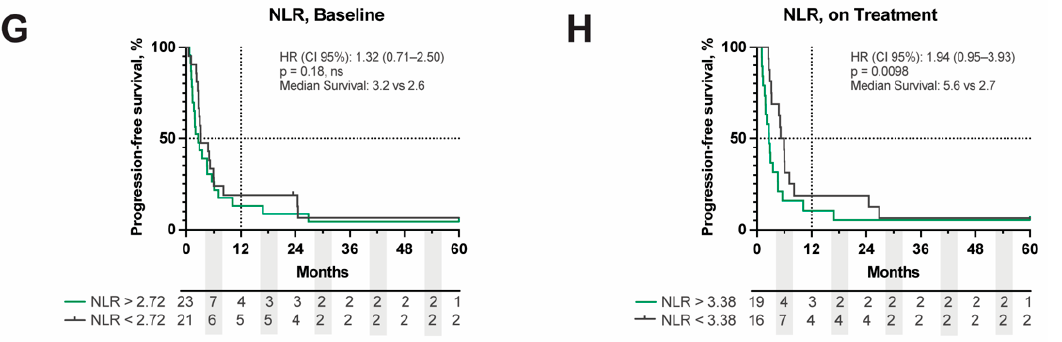
Figure 2. Kaplan–Meier curve of OS and PFS stratified by LDH value above or below 240 mg/dL at baseline ( A , C ) and on treatment ( B , D ). OS and PFS of NLR stratified by the median cut point of 2.72 at baseline ( E , G ) and 3.38 on treatment ( F , H ). Dashed lines represent 50%- and 12-month survival points, respectively. Hazard ratios (HR), p -values, and median survival are displayed in the upper right corner of each respective graph. Baseline = ICB start; on treatment = response assessment 8 weeks following ICB initiation. LDH = lactate dehydrogenase, NLR = neutrophil:lymphocyte ratio, OS = overall survival, PFS = progression-free survival.